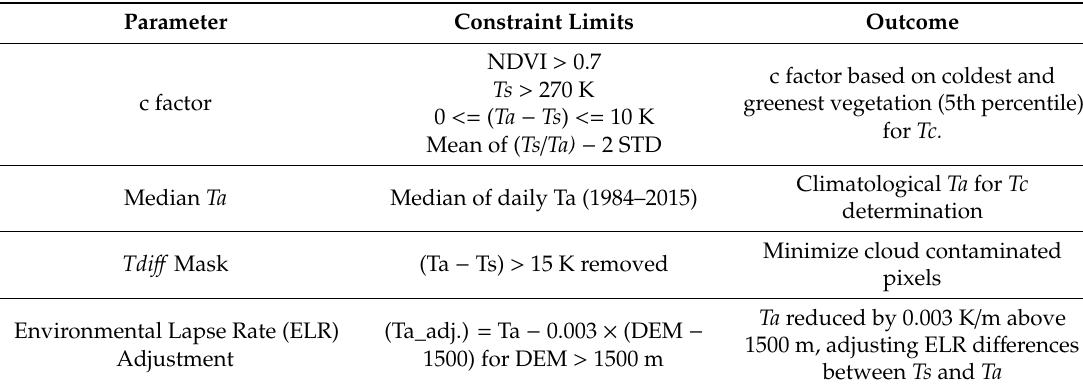
Table 1. SSEBop model parameter description and constraint